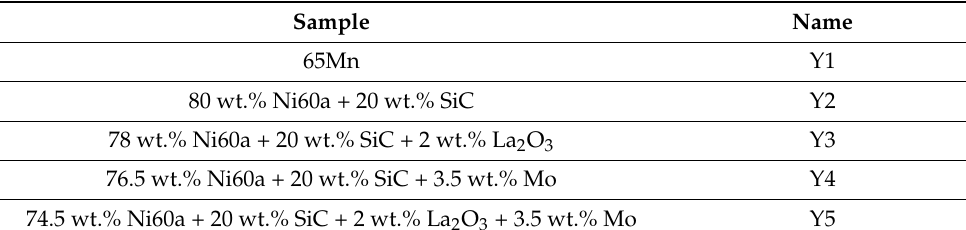
Table 2. Proportioning scheme of laser cladding powder.